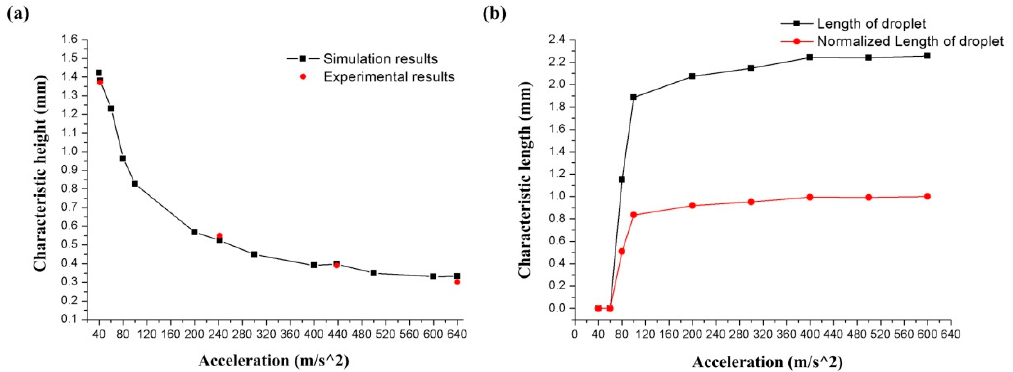
Figure 12. The characteristic sizes of the droplet deformation in different acceleration: ( a ) shows the results of C-height; ( b ) shows the results of C-length.